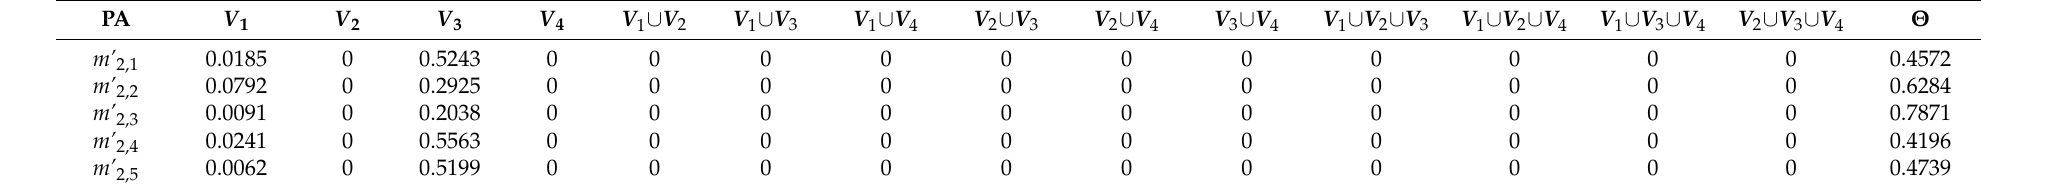
Table 12. Probability assignments of without crack-transverse crack sub-classifier for an image of a transverse crack.